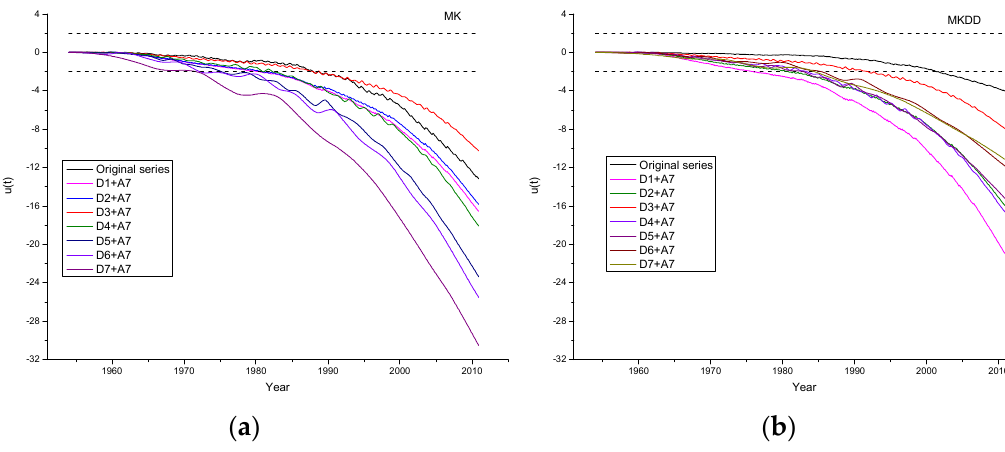
Figure 10. Two sequential Mann-Kendall (MK and MKDD) graphs of monthly streamflow series exhibiting the progressive trend lines of each detail component (with the addition of the approximation) with respect to the original series. The upper and lower dashed lines represent the confidence limits ( α = 5%). ( a ) MK; ( b ) MKDD. Table 5. Lag-one ACFs, Mann-Kendall values (three MK tests) and energy of monthly total precipitation series: original data, details components (D1–D6), approximations (A6) and a set of combinations of the details and their respective approximations. C 0 is the correlation coefficients between the decomposition combinations and the original